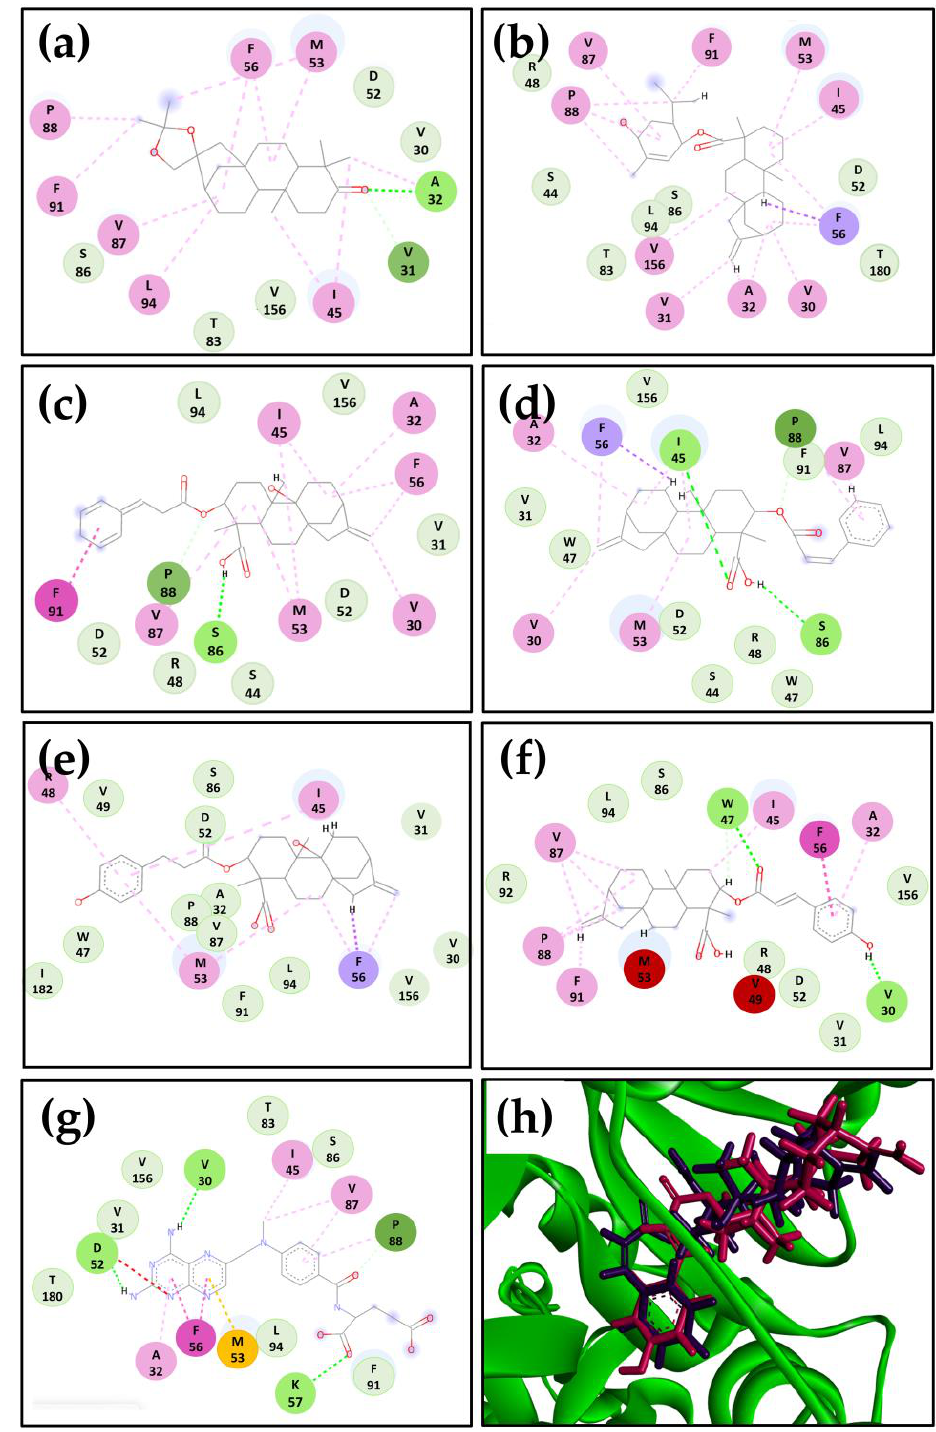
Figure 2. Two-dimensional residual interaction diagrams in the active site of L. major DHFR-TS for: ( a ) structure 4 , ( b ) structure 135 , ( c ) structure 301 , ( d ) structure 302 , ( e ) structure 301a , ( f ) structure 302a and ( g ) methotrexate (MTX). Interacting residues are shown as colored circles depending on the interactions (as colored dashed lines): H-bond (lime), van der Waals (green), π – σ (purple), π – alkyl (pink), π – π (fuchsia), unfavorable (red), and carbon H-bond (teal) interactions. ( h ) Docking conformations of structure 302 (purple) and its derivative 302a (pink) in the active site of L. major DHFR-TS (green).